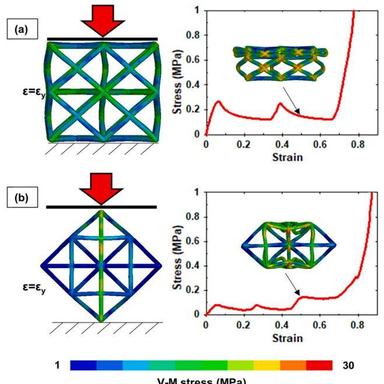
Mechanical responses of FCC lattice when the loading is applied in different directions with respect to the struts of the cells. a) Stretch dominated behaviour, and b) combined bending-stretch-dominated behaviour.